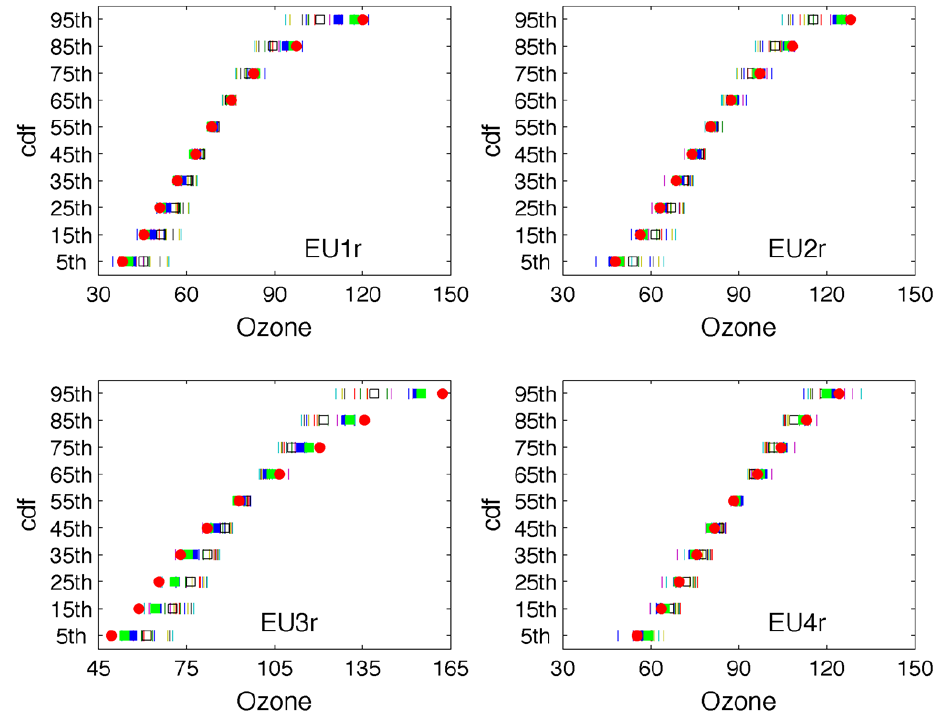
Figure 2. Cumulative density function of observations (red circle) and models (coloured lines). At the same plot, the three ensemble esti- mators are also displayed, namely the multi-model ensemble mean (mme: square), the optimal weighted ensemble estimator (mmeW: green circle) and the optimal accuracy–diversity ensemble estimator (mmeS: blue circle). Please note the different range of the x -axis between the different